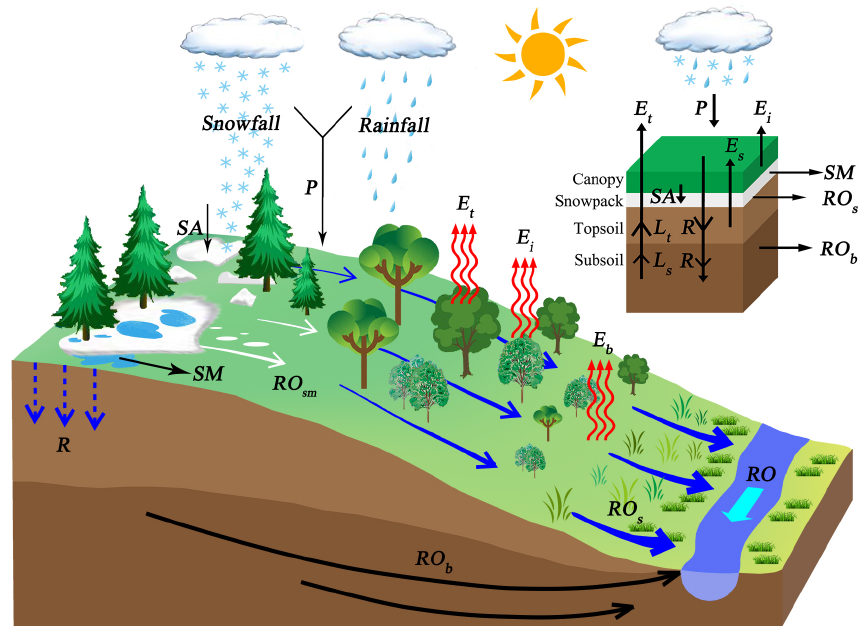
Figure 2. Schematic diagram of the relative physical processes included in the construction of the SZI snow . The upper right subplot shows the variables used in the SZI snow calculations at the pixel level. Full names of all the abbreviations in this figure are listed in Table